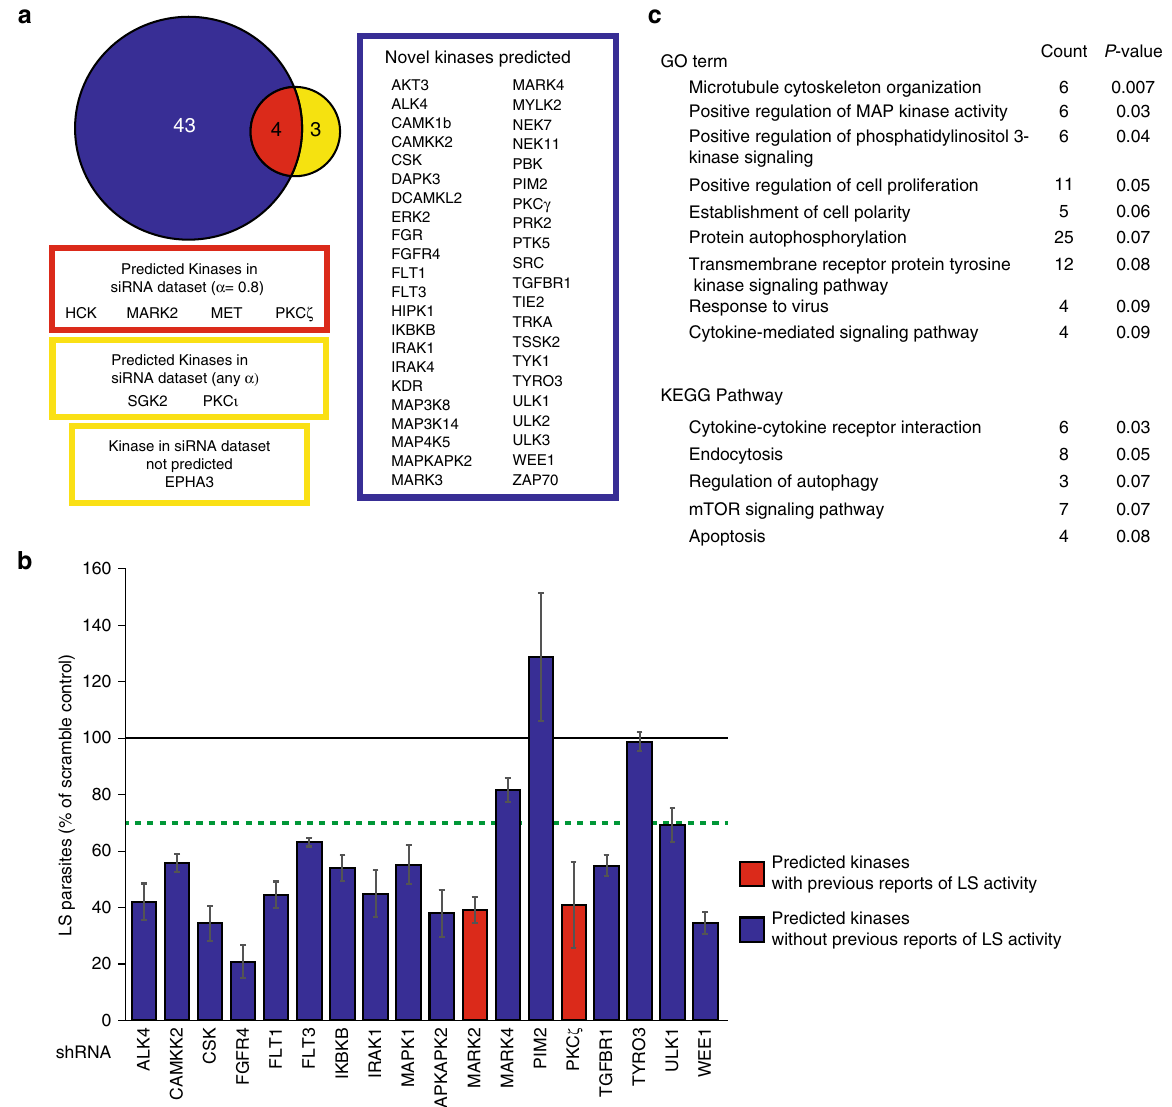
Fig. 3 Kinase pro fi ling and elastic net regression successfully predict known and novel host kinases important for regulating P. yoelii LS infection. a Venn diagram depicting overlap between predicted kinase hits and kinases previously reported by whole-kinome siRNA screen. Our approach predicted 47 host kinases to be regulators of Plasmodium LS infection. Kinases without any previously described role in LS infection are depicted in blue. Kinases previously implicated in LS infection, and also predicted by the elastic net regression at α = 0.8, are depicted in red. Of the kinases previously demonstrated to regulate Plasmodium LS infection, those which are predicted at α < 0.8 are depicted in yellow. Kinases not recapitulated by our approach at any value of α are shown below. Statistical comparison to existing data was performed using hypergeometric probability test ( p = 0.01). b Bar graph depicting LS development in cells with shRNA-mediated knockdown of a subset of predicted kinases. Values are normalized to non-treated parasites which are indicated by solid line. Green dashed line represents LS burden ≤ 70% of control. Predicted kinases with previous reports of LS activity are depicted in red. Novel predicted kinases are depicted in blue. Data is representative of at least three independent experiments. Error bars represent standard deviation of technical replicates. c Functional enrichment analysis of predicted kinases. The 47 predicted host kinases were analyzed using DAVID Bioinformatics Resources 6.8 25,26 . The 300 kinases that are evaluated by this approach were set as the background for the analysis. P -values were determined